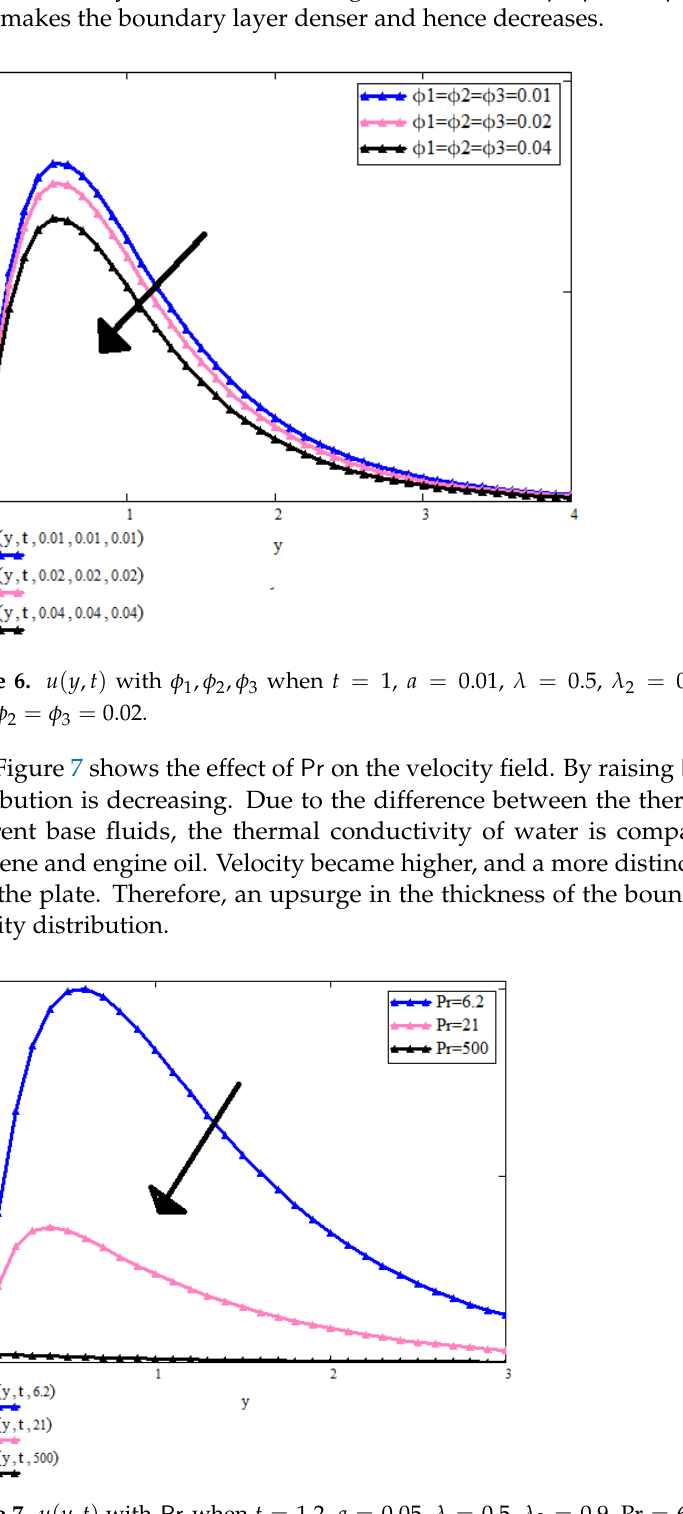
Figure 7. u ( y , t ) with Pr when t = 1.2, a = 0.05, λ = 0.5, λ 2 = 0.9, Pr = 6.2, β 1 = 0.9, φ 1 = φ 2 = φ 3 =